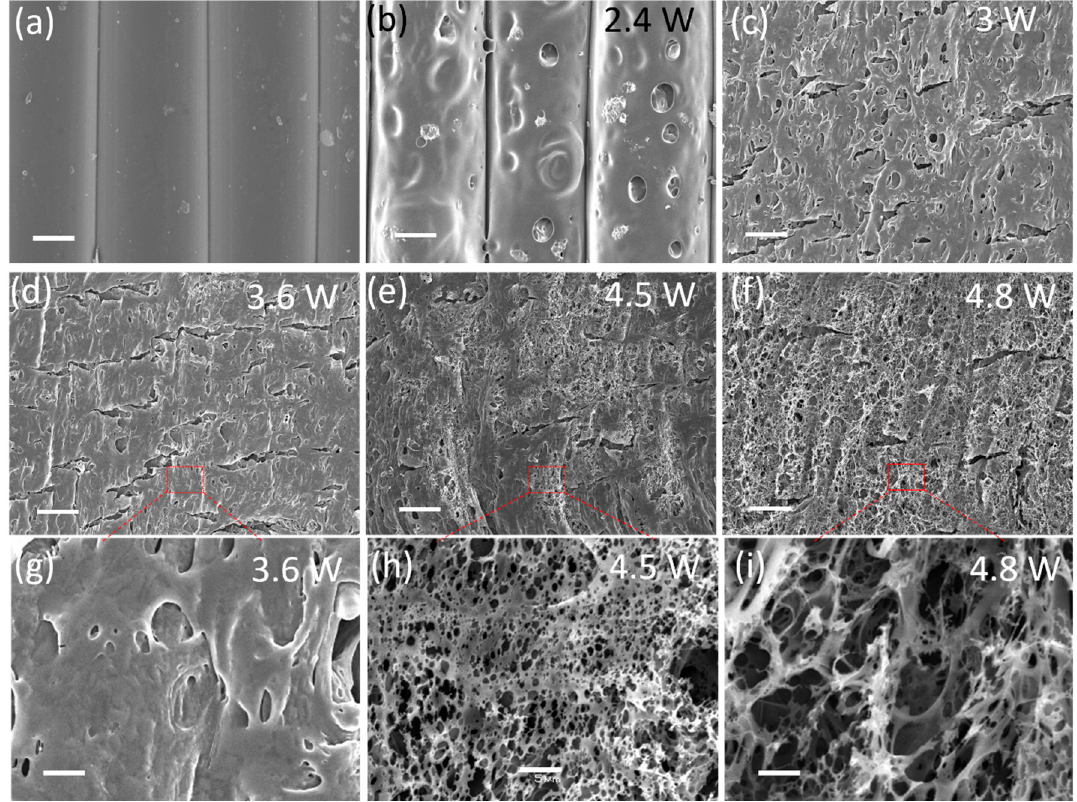
Figure 2. SEM images of the AM parts: Original surface ( a ); surface processed by CO 2 laser with a power of 2.4 W ( b ), 3 W ( c ), 3.6 W ( d ), 4.5 W ( e ), and 4.8 W ( f ). Scale bar: 100 μ m. The SEMs in the